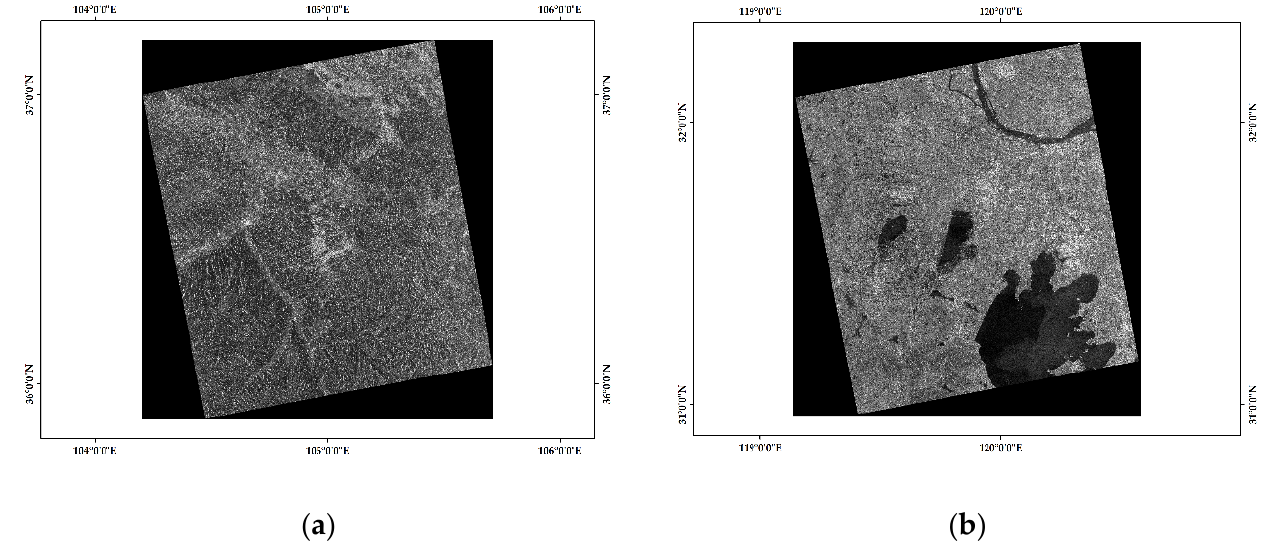
Figure 7. Test images for quantitative evaluation: ( a ) T1 from Gansu and ( b ) T2 from Jiangsu. Table 3. The information of the GF-3 and Sentinel-1 SAR data of the study areas.